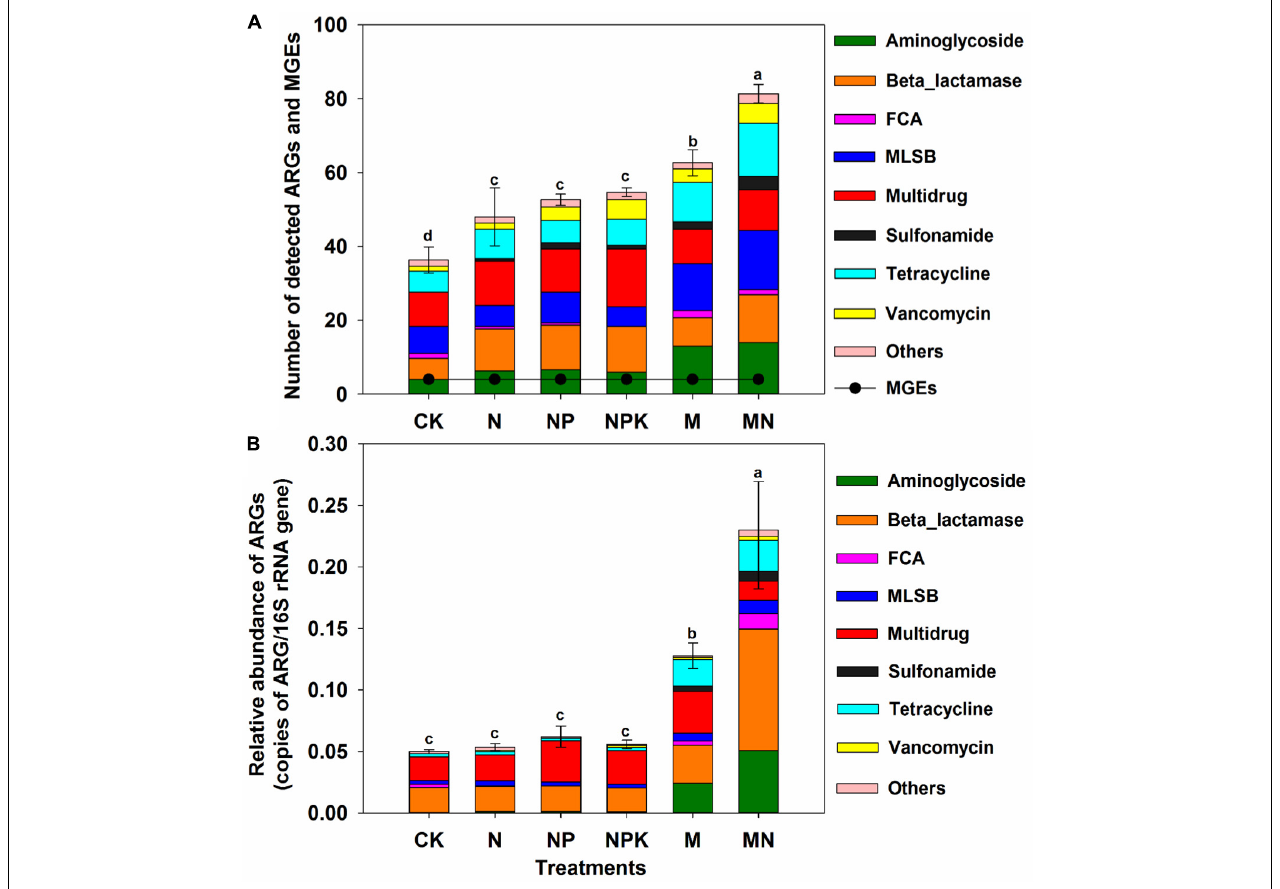
FIGURE 2 | (A) Number of detected ARGs and MGEs in the different treatments. (B) The relative abundance of ARGs in the different treatments. FCA, fluoroquinolone, quinolone, florfenicol, chloramphenicol, and amphenicol; MLSB, macrolide-lincosamide-streptogramin B; MGEs, mobile genetic elements. Different letters indicate significant differences of means in pairwise comparisons (Duncan’s test, P < 0.05) for each